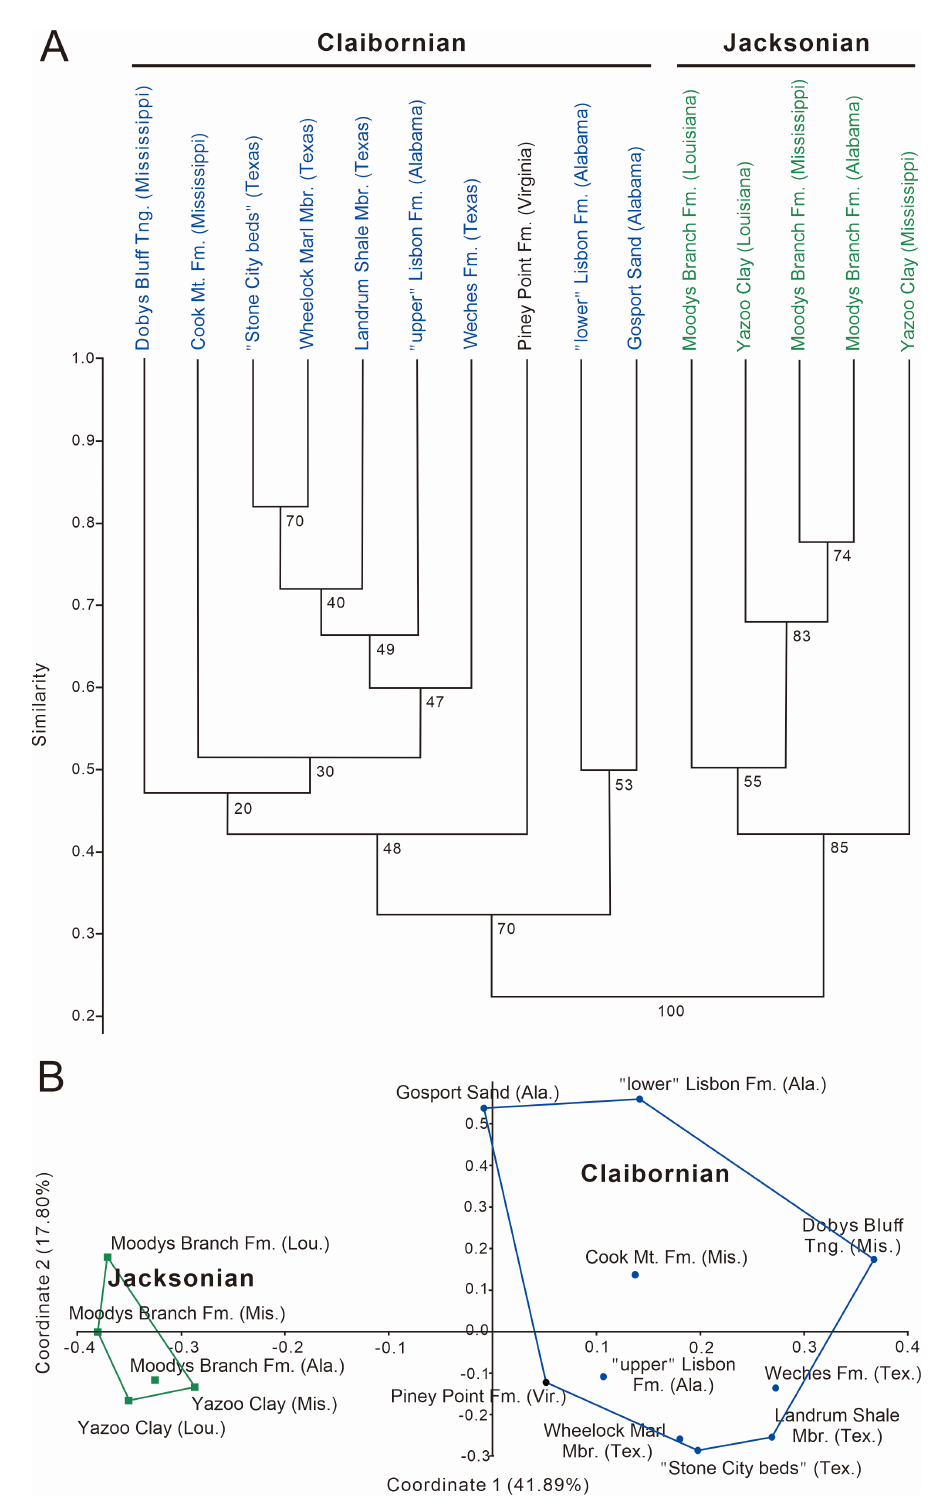
Fig. S1. Comparison of Claibornian and Jacksonian otolith assemblages from the middle and late Eocene of the eastern and southern USA. A cluster analysis ( A ) and a principal coordinate analysis, PCoA ( B ) with Bray-Curtis similarity index were performed based on the taxonomic composition (presence/ absence) of each assemblage. Bootstrap values are given at the roots of each cluster in ( A